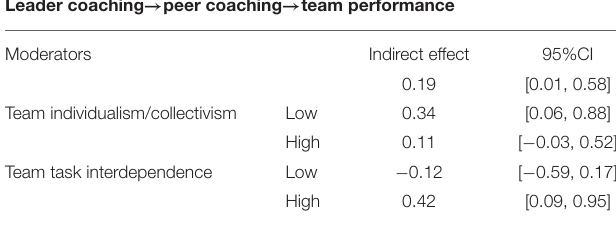
TABLE 3 | Indirect and moderated indirect